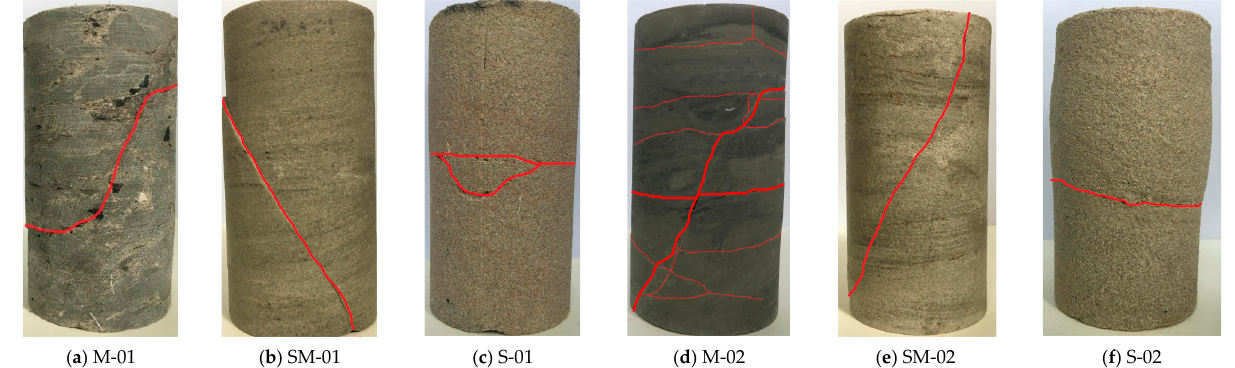
Figure 5. Failure characteristics of mudstone, sandy mudstone, and sandstone. ( a ) Constant confining pressure test of mudstone; ( b ) Constant confining pressure test for sandy mudstone; ( c ) Constant confining pressure test of sandstone; ( d ) Mining stress test of mudstone; ( e ) Mining stress test of sandy mudstone; ( f ) Mining stress test of sandstone.